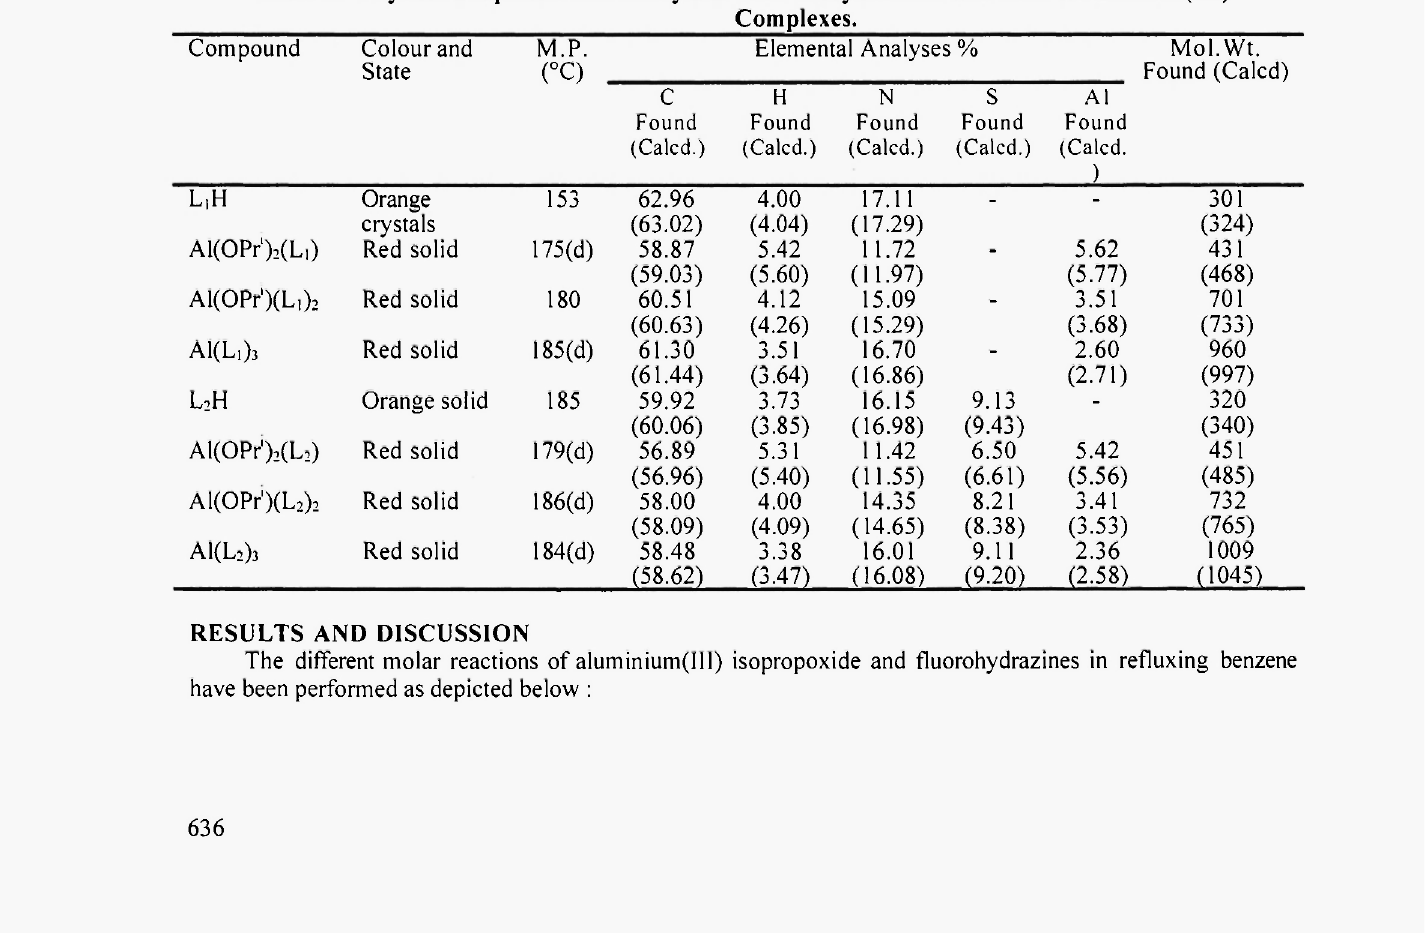
Table 1:- Physical Properties and Analytical Data of Hydrazines and their Aluminium(III)